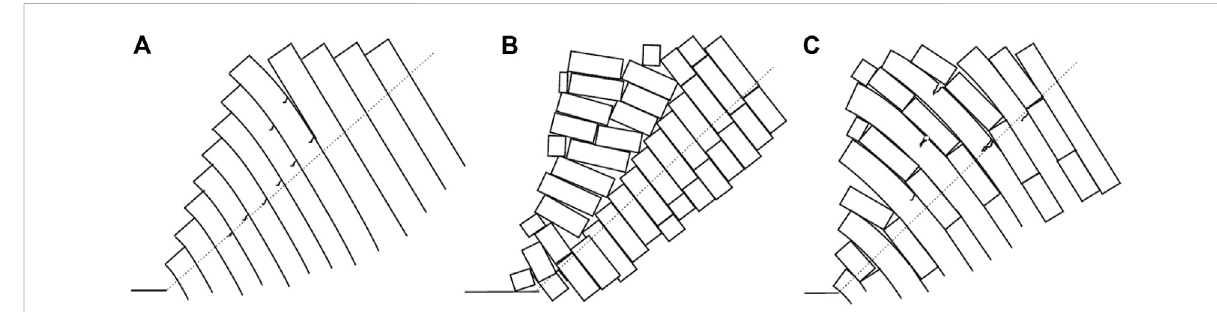
FIGURE 1 Anti-inclined bedded rock slopes: (A) fl exural-toppling; (B) blocky-toppling; (C) block- fl